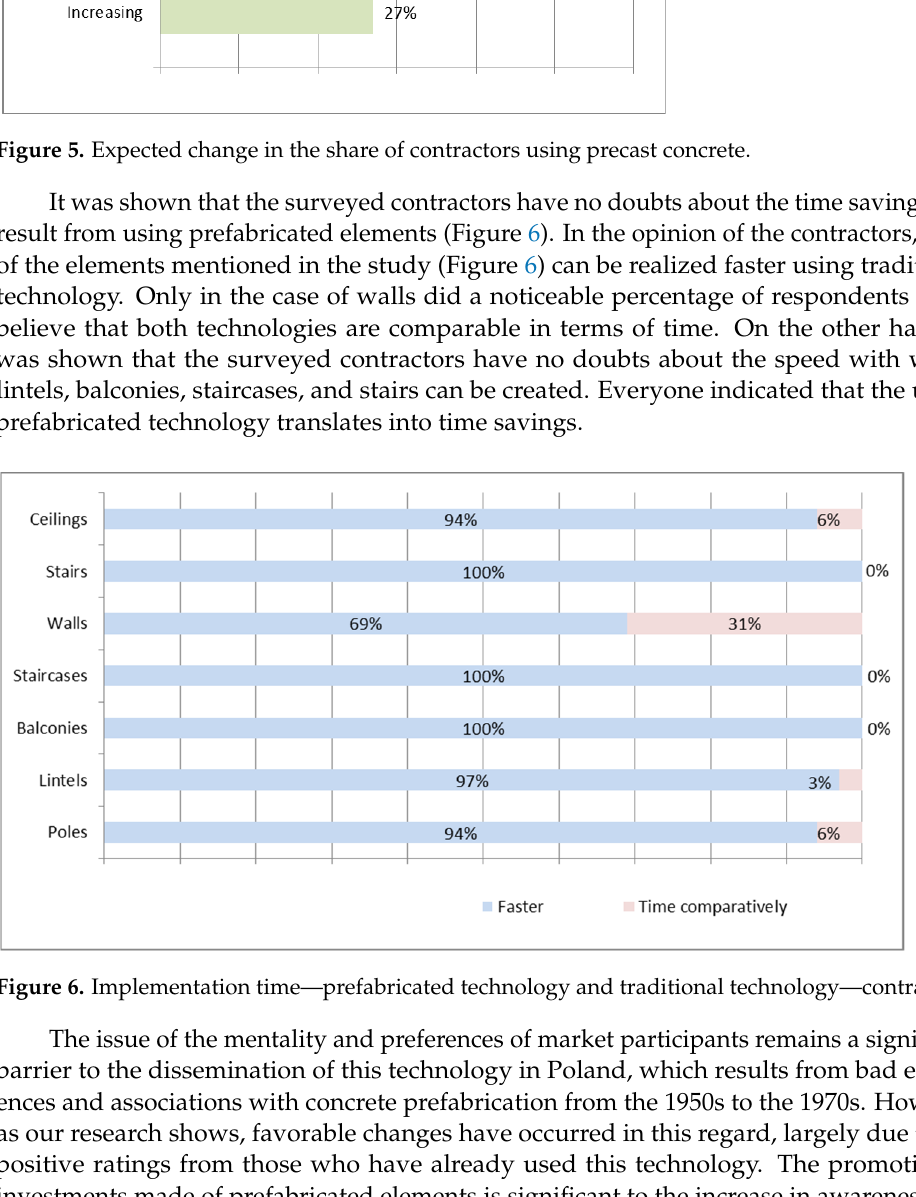
Figure 5. Expected change in the share of contractors using precast concrete.